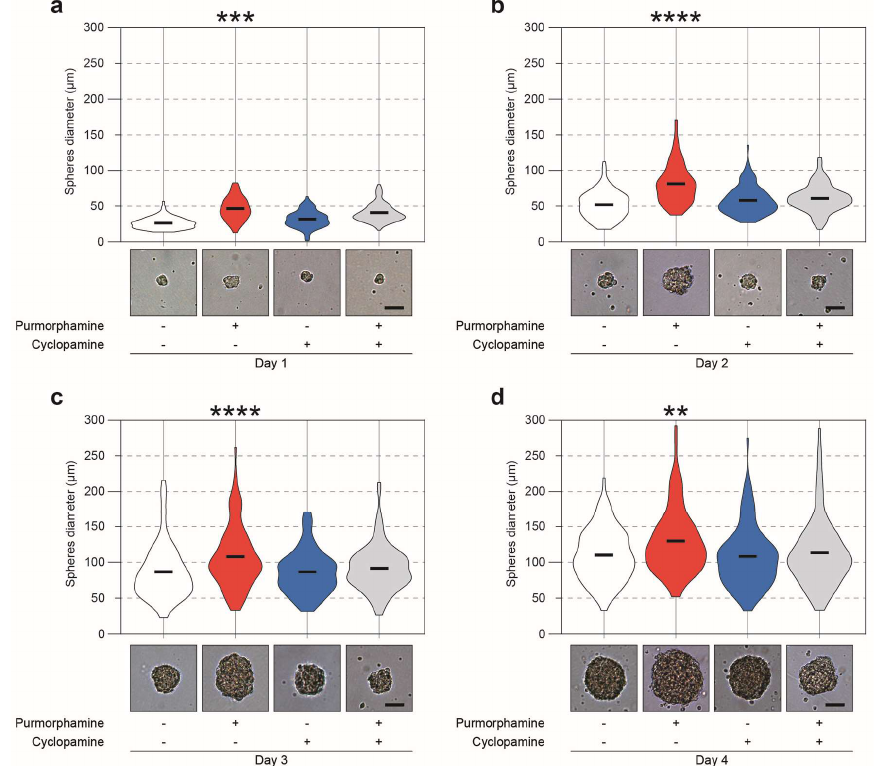
Figure 3. Shh pathway increases NSC neurosphere dimensions. ( a – d ) Violin plot of neurosphere diameters (expressed in µ m) from day 1 ( a ), 2 ( b ), 3 ( c ) and 4 ( d ) in control (white) cultures and upon purmorphamine (red), cyclopamine (blue) or purmorphamine plus cyclopamine (gray) stimulation in vitro. Data from n ≥ 3 independent experiments. Scale bar 50 µ m. ** p -value < 0.01, *** p -value < 0.001 and **** p -value < 0.0001 vs. day